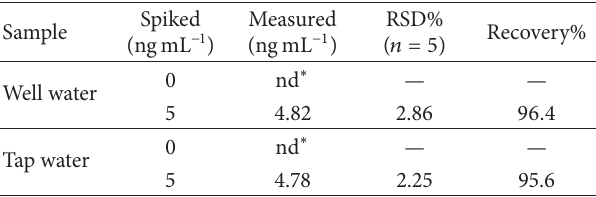
Table 4: Determination of zinc(II) in water